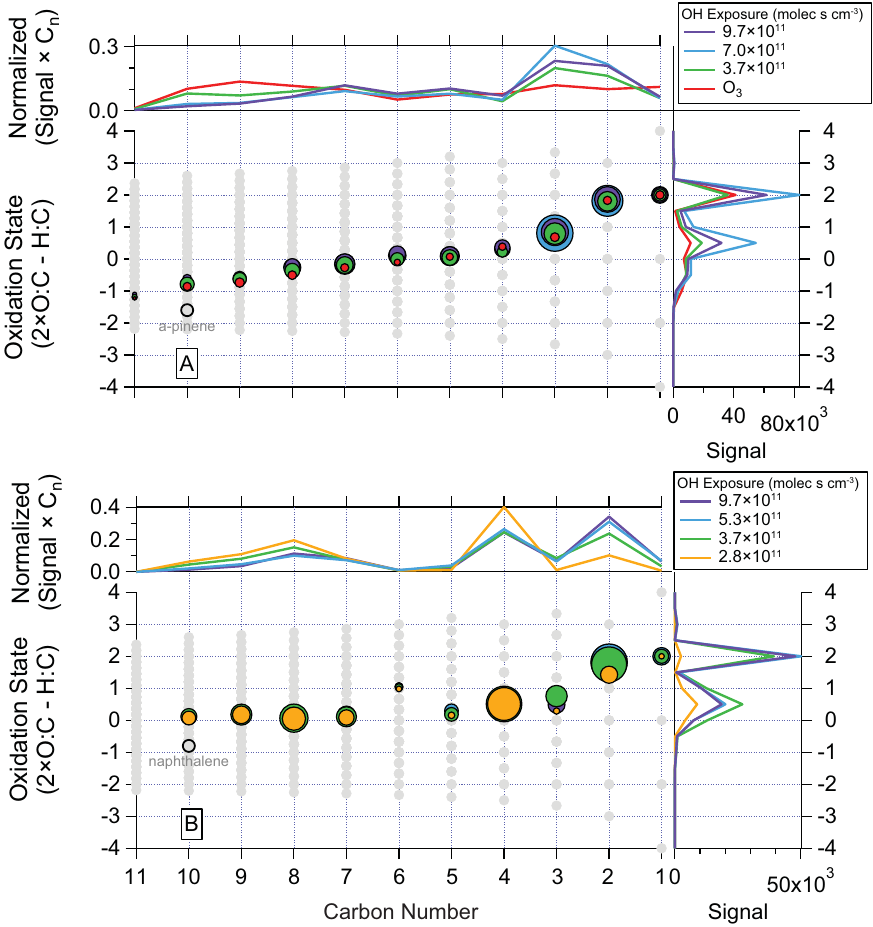
Figure 4. Kroll diagram for α -pinene (a) and naphthalene (b) oxidation experiments. The main panel displays the average OS C per carbon number for each oxidation experiment. The area of the marker is proportional to the signal times the carbon number. The top panel plots the fraction of carbon-weighted signal at each carbon number. The right panel displays the signal distribution across oxidation